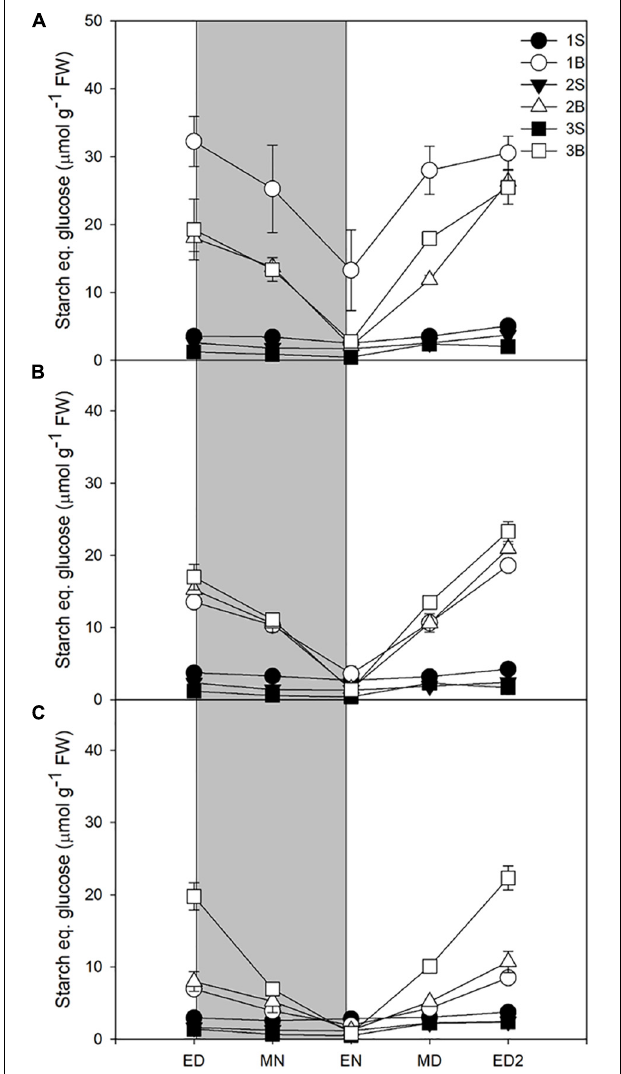
FIGURE 2 | Diurnal starch levels of barley cv. Propino plants grown under three light intensities. Starch levels of plants grown for (A) 14 DAS under 500 µ mol photons m − 2 s − 1 (HL), (B) 16 DAS under 300 µ mol photons m − 2 s − 1 (ML) and (C) 18 DAS under 100 µ mol photons m − 2 s − 1 (LL), until third leaf stage. Plants were grown in a 16 h:8 h light:dark photoperiod 22 ◦ C:18 ◦ C day:night. 1S: 1 st leaf sheath; 1B: 1 st leaf blade; 2S: 2 nd leaf sheath; 2B: 2nd leaf blade; 3S: 3rd leaf sheath; 3B: 3 rd leaf blade; ED: end of day; MN: middle of night; EN: end of night; MD: middle of day; ED2: end of subsequent day; FW: fresh weight; gray panels: night period; error bar represents SD; n = 3. Statistical analyses were performed to assess differences between time points, tissues and light treatments by ANOVA with Tukey’s post hoc test P < 0.05, and results are available in Supplementary